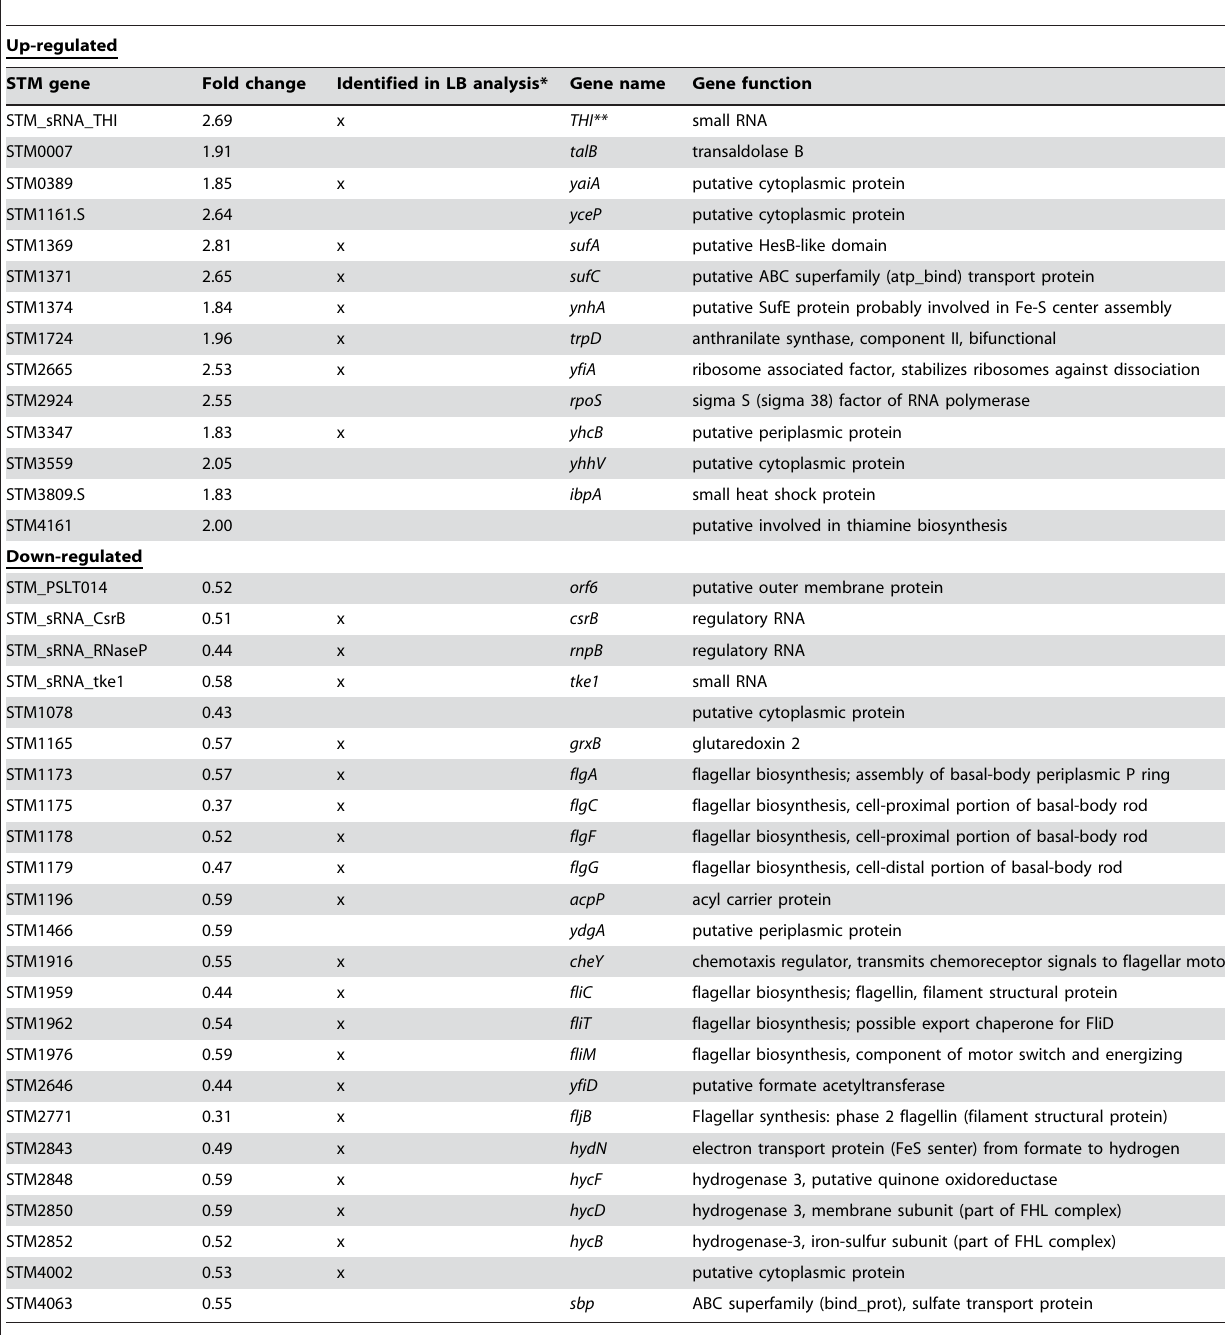
Table 2. Salmonella typhimurium genes altered in expression during growth in M9 minimal media in